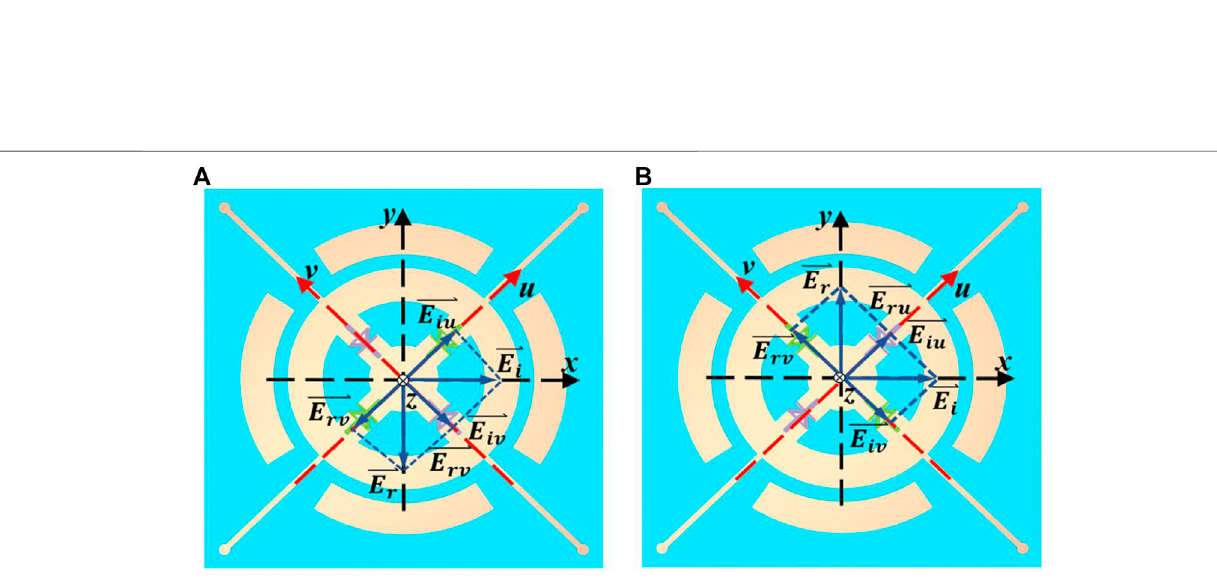
Frontiers in Materials |